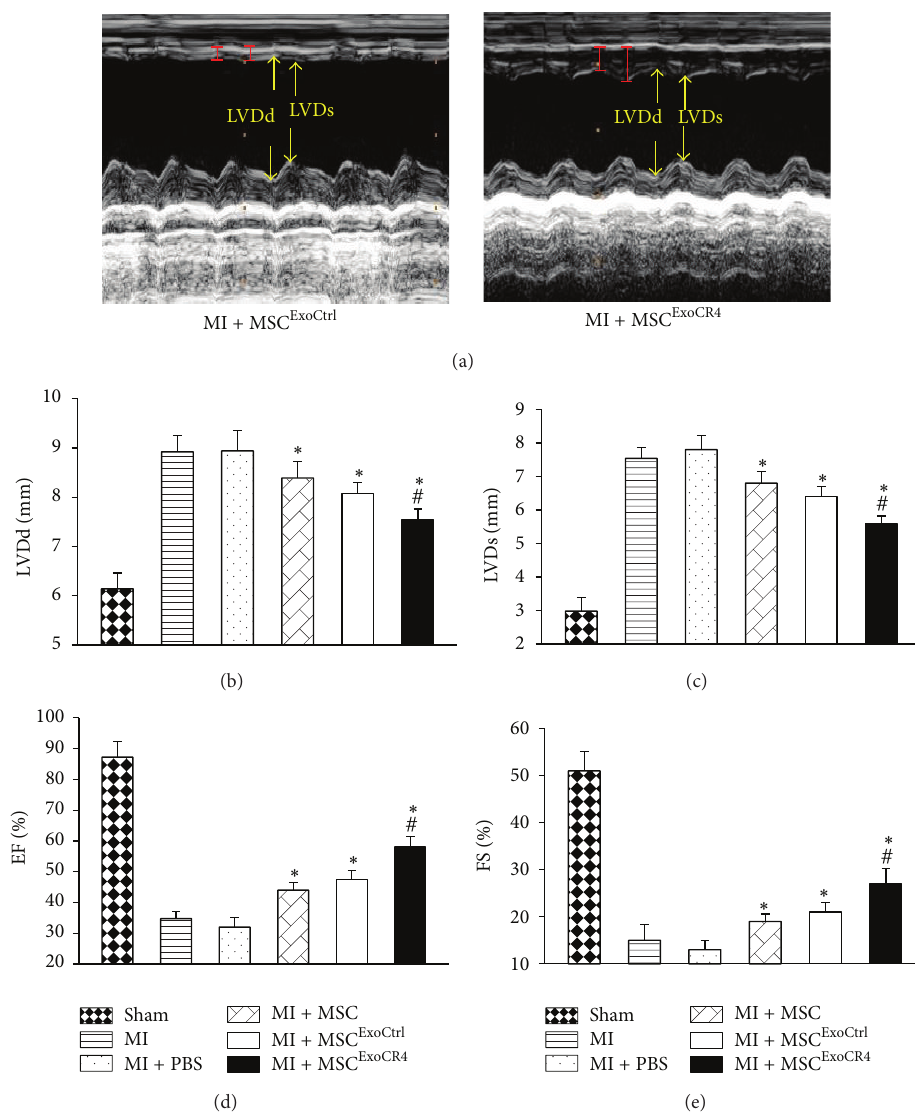
Figure 7: Cardiac function assessed by echocardiography at 4 weeks after cell patch graft. (a) M-mode echocardiography data in various experimental groups. ((b)–(e)) Quantification analysis for LVDd, LVDs, EF, and FS. LVDd: left ventricular diastolic left ventricular diameter, LVDs: systolic left ventricular diameter, EF: left ventricular ejection fraction, and FS: left ventricular fraction shortening. # 𝑃 < 0.05 versus MI + MSC ExoCtrl group. ∗ 𝑃 < 0.05 versus MI; # 𝑃 < 0.05 versus MI + MSC. All values expressed as mean ± SEM, 𝑛 = 6 for each